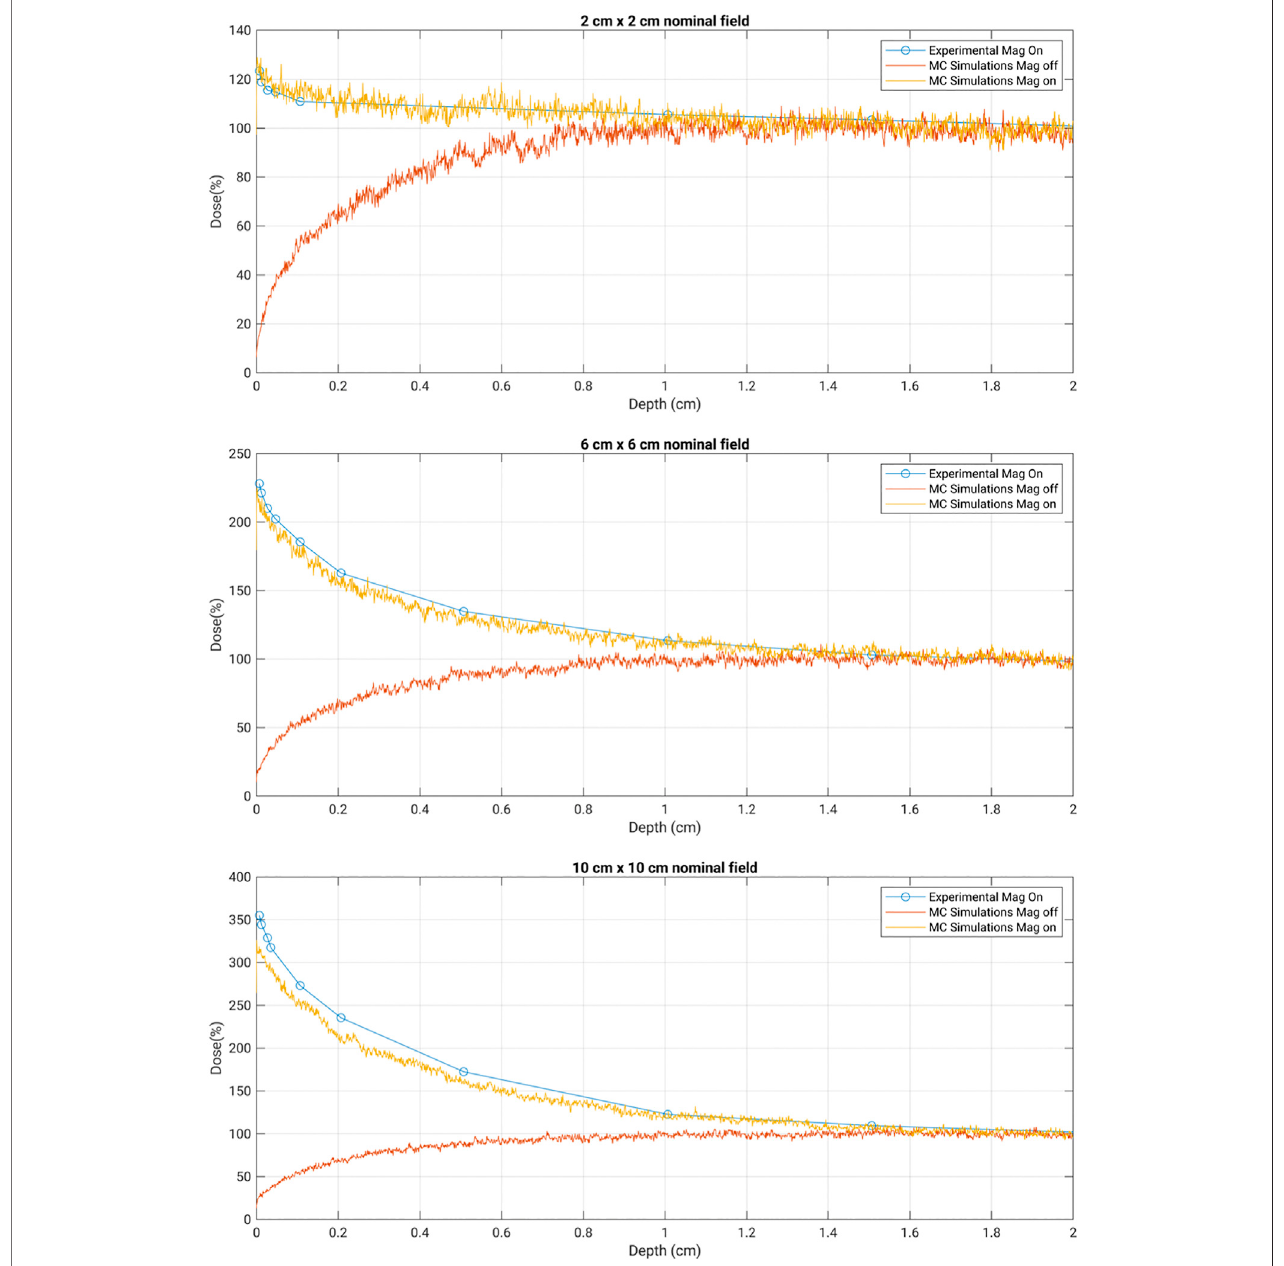
FIGURE 3 | Depth dose curves for the nominal fi eld sizes of 2 cm × 2 cm, 6 cm × 6 cm, and 10 cm × 10 cm. Experimental data were collected with MO Skin ™ in 1 T MRI-Linac. MC simulation results were obtained with a magnetic fi eld on and off for comparison.